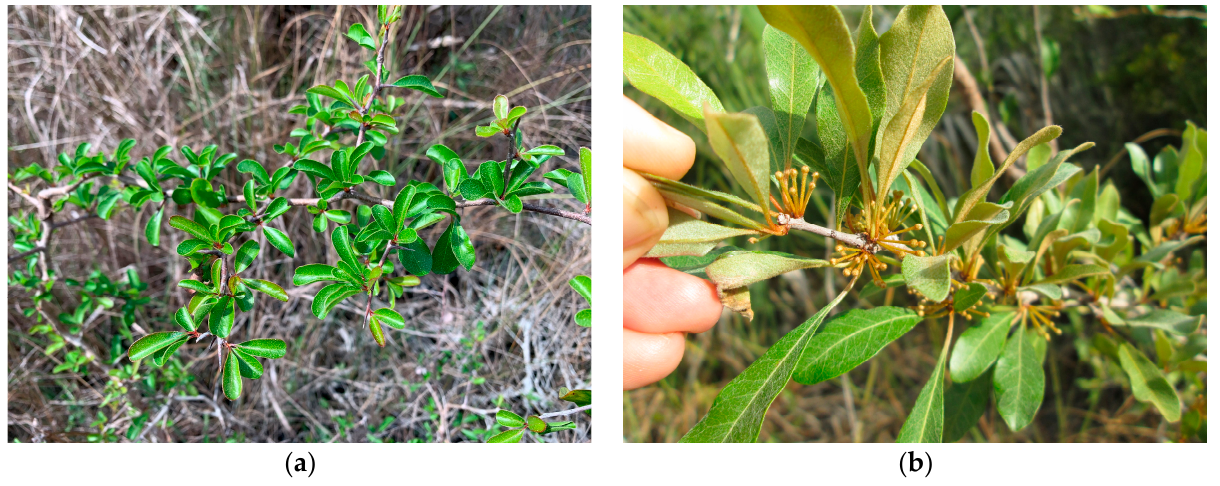
Figure 1. In situ specimens of S. reclinatum ( a ) superficially resembling subsp. reclinatum with glabrous surfaces from Big Cypress National Preserve, and ( b ) characteristic subsp. austrofloridense with rufous-tomentose abaxial surfaces, and pubescent pedicels and calyx from Everglades National Park. Shortly thereafter, Corogin and Judd [15] published a detailed analysis of the two subspecies using micromorphological characters of abaxial leaf surfaces, which they con- sidered to be more reliable than pubescence. This approach had previously been applied by Anderson [16] in distinguishing the rare S. thornei (Cronquist) T.D.Penn. from superficially similar congeners. Corogin and Judd’s analysis revealed that both subspecies are cryptically sympatric in BICY. Of five (5) specimens examined from the southern portion of BICY,